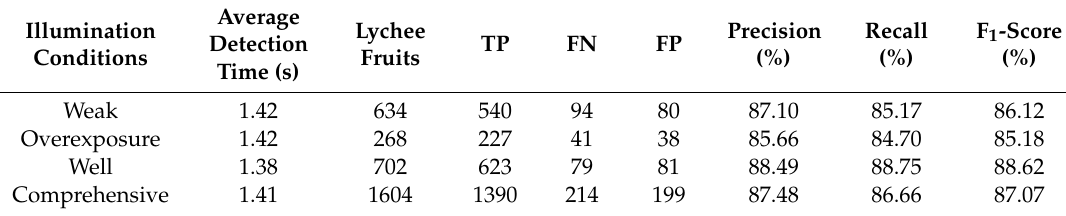
Table 4. Lychee fruit detection results in an orchard environment using the LBP-SVM